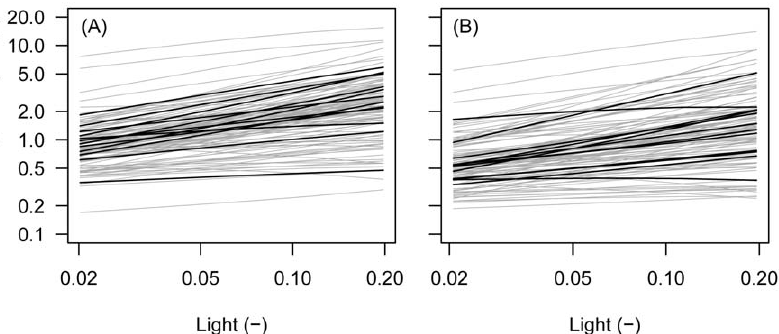
Figure 5. Visual assessment of the scope for light gradient partitioning. Predicted average growth rates (mm/yr) in (A) 1985–1990 and (B) 1990–1995 across most common light conditions (2–20%) for species with $ 100 individuals. Twelve randomly selected species are highlighted in black. Intersections of lines represent reversals of growth rankings between species.